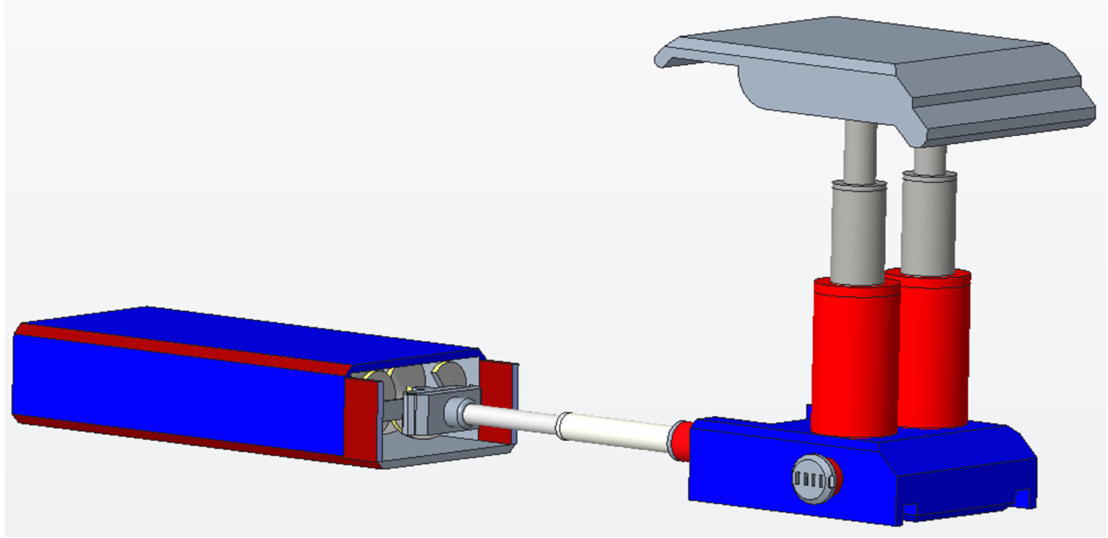
Figure 5. Hydraulic support integrated with addcar (performed by the